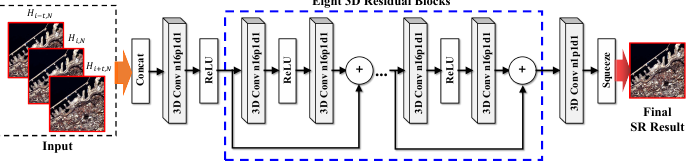
Figure 5. Architectures of the 3D feature fusion subnetwork Fnet with corresponding number of feature maps ( n ), padding ( p ) size, and dilation ( d ) size. The kernel size and stride size of all the 3D convolution layers are set to 3 and 1,